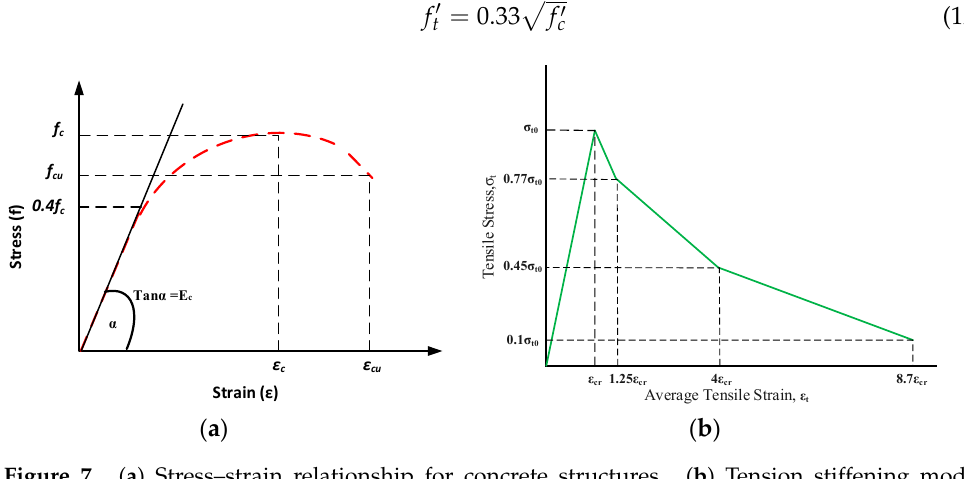
Figure 7. ( a ) Stress–strain relationship for concrete structures. ( b ) Tension stiffening model for concrete.